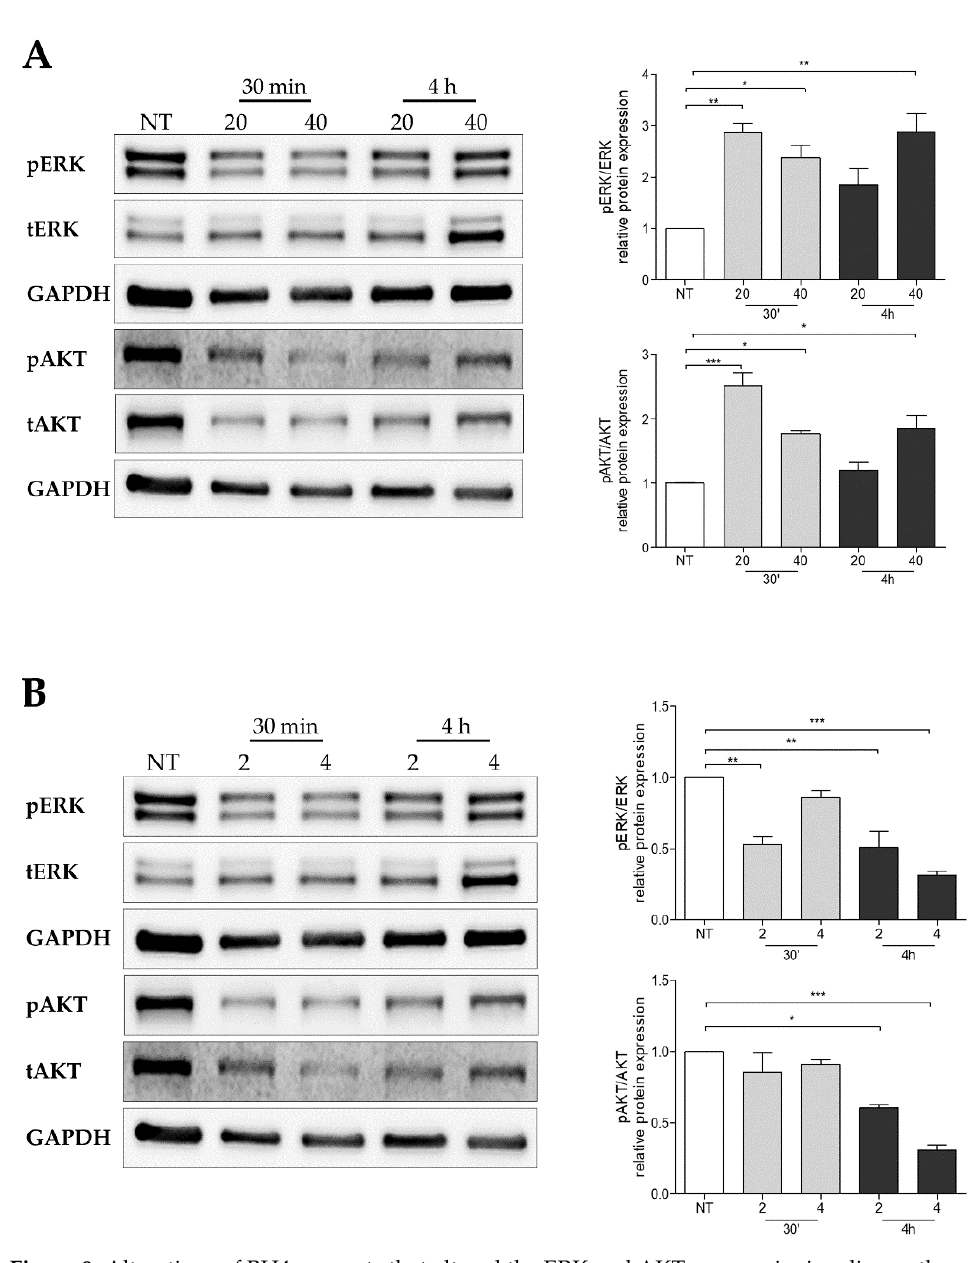
Figure 9. Alterations of BH4 amounts that altered the ERK and AKT oncogenic signaling pathways. Activation of the ERK and AKT pathways was analyzed in WM1552 radial growth melanoma cells treated with 20 and 40 µM BH4 for 30 min and 4 h ( A ) and, in WM983B metastatic melanoma cells, treated with 2 and 4 mM DAHP for 30 min and 4 h ( B ) by Western blot using specific antibodies for phospho- and total ERK and phosphor- and total AKT. GAPDH was used as the internal control. The Western blot images show the representative results of three independent experiments. Values are reported in the bar graphs and expressed as the means ± S.D. The experiments were performed in triplicate, and the p -values were based on the one-way ANOVA test, followed by Bonferroni’s post-test; *, p < 0.05, **, p < 0.01 and ***, p < 0.001.